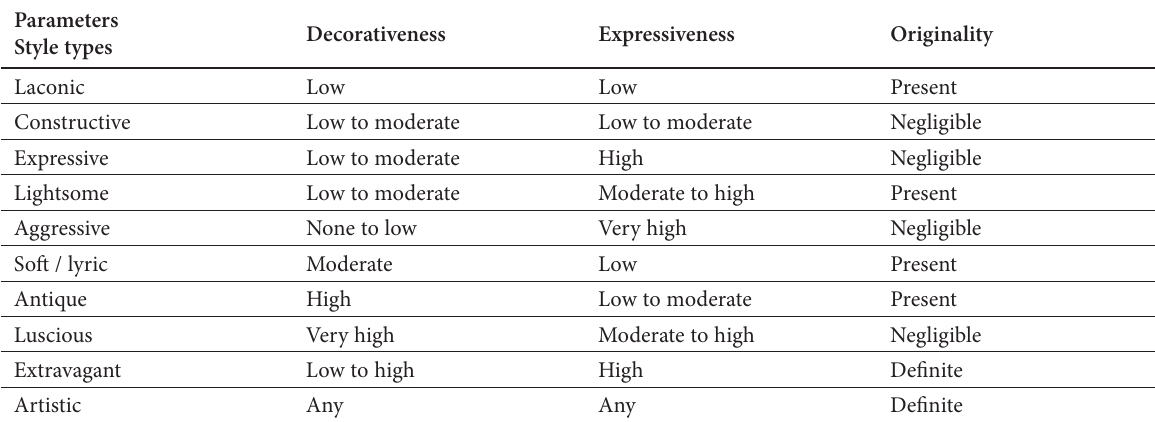
Table 3. Frequent stylistic groups of modern maps